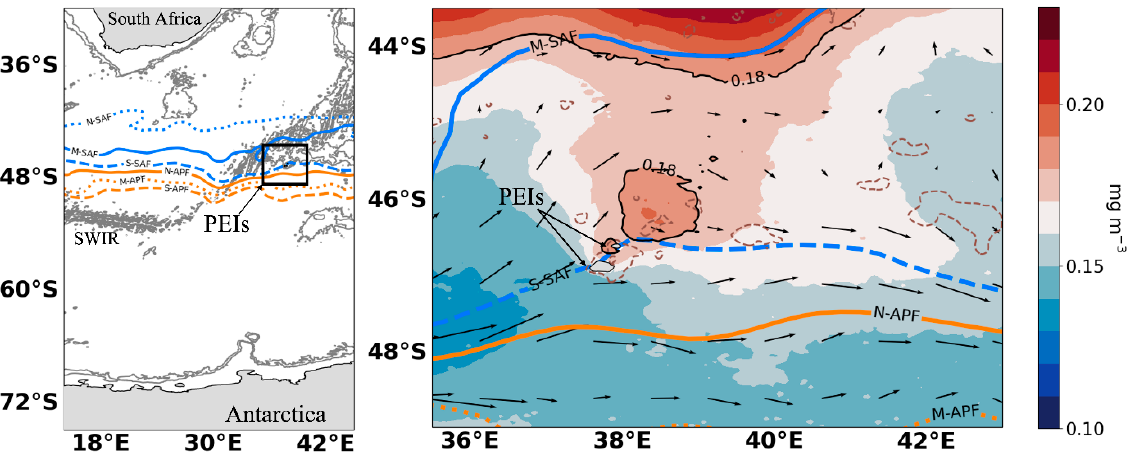
Figure 1. ( left ) Bathymetry map indicating the location of the Prince Edward Islands (PEIs) in relation to South Africa and Antarctica. The grey contours indicate the 1000, 2000, and 3000 m isobaths. ( right ) Long-term mean Copernicus-GlobColour chlorophyll a (chla; mg m − 3 ) in the PEI region. The black contours illustrate the 0.18 mg m − 3 chla isopleths, and the dashed brown contours indicate the 1000 m isobath. The solid and dashed thick blue lines indicate the long-term mean positions of the middle (M-SAF) and southern (S-SAF) branches of the sub-Antarctic Front, respectively, while the solid and dotted thick orange lines show the long-term mean positions of the northern (N-APF) and middle (M-APF) branches of the Antarctic Polar Front, respectively.